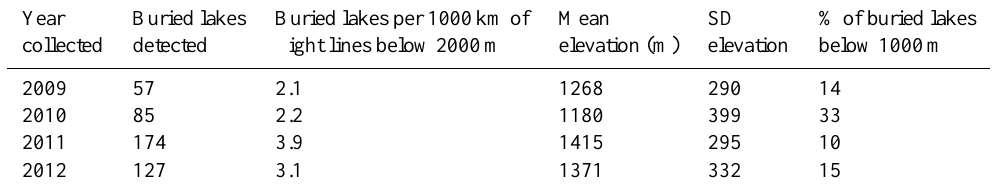
Table 1. Number of buried lakes detected in each year along with the number of lakes detected perkm of flight lines below 2000m, the mean elevation and standard deviation of buried lake elevations and the percentage of buried lake below 1000m in elevation. See Fig. 6 for spatial distribution. Year Buried lakes Buried lakes per 1000km of Mean